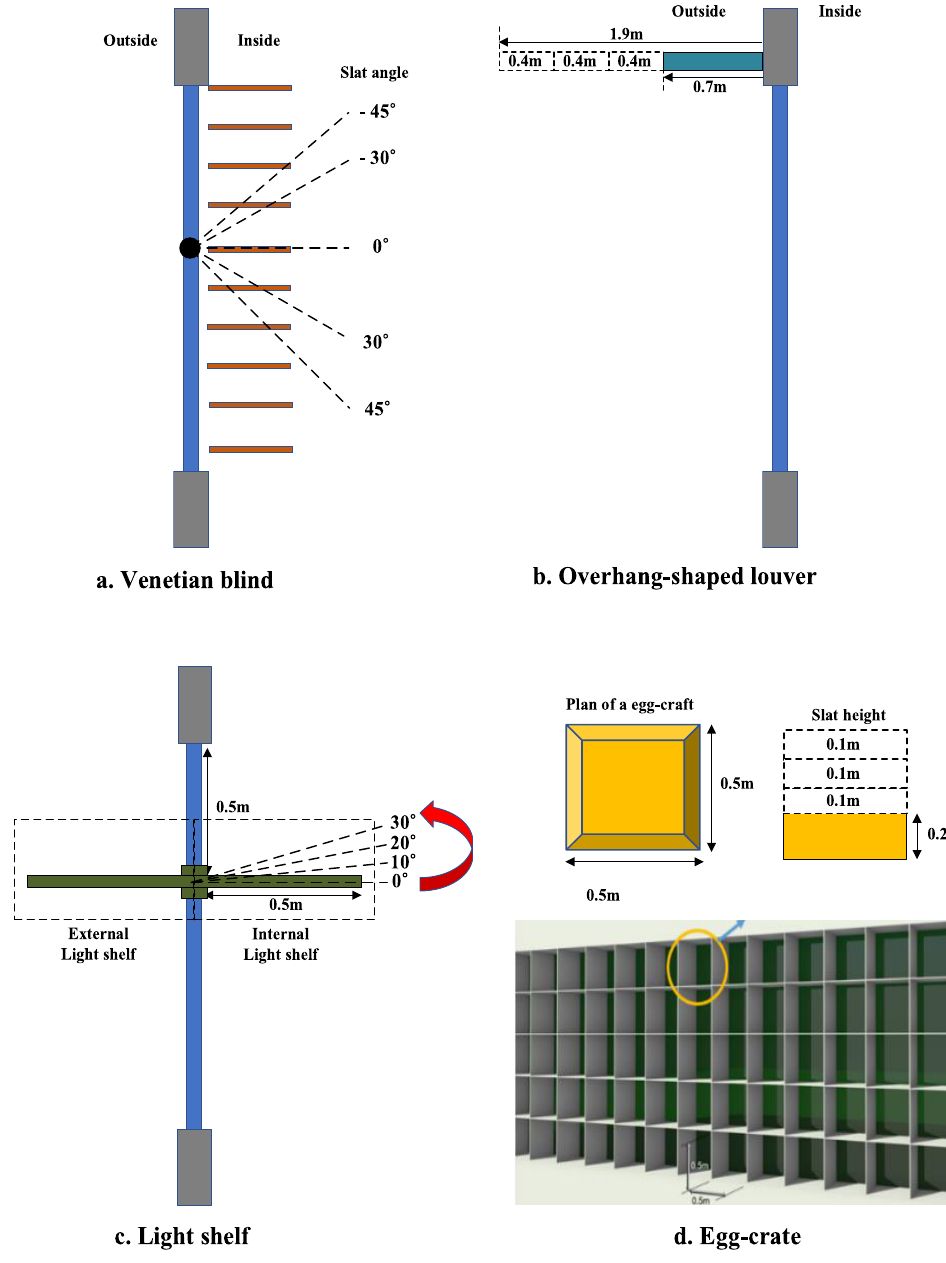
Figure 2. Design variables of the shading devices. Table 2. The design variables of shading